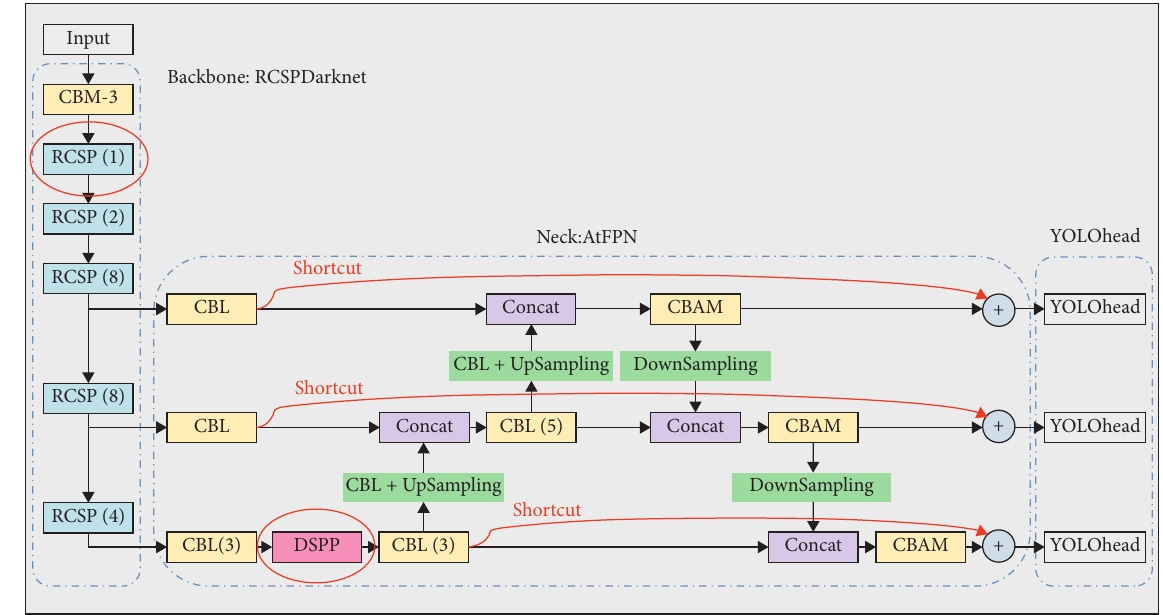
Figure 7: Schematic diagram of the ShipYOLO model